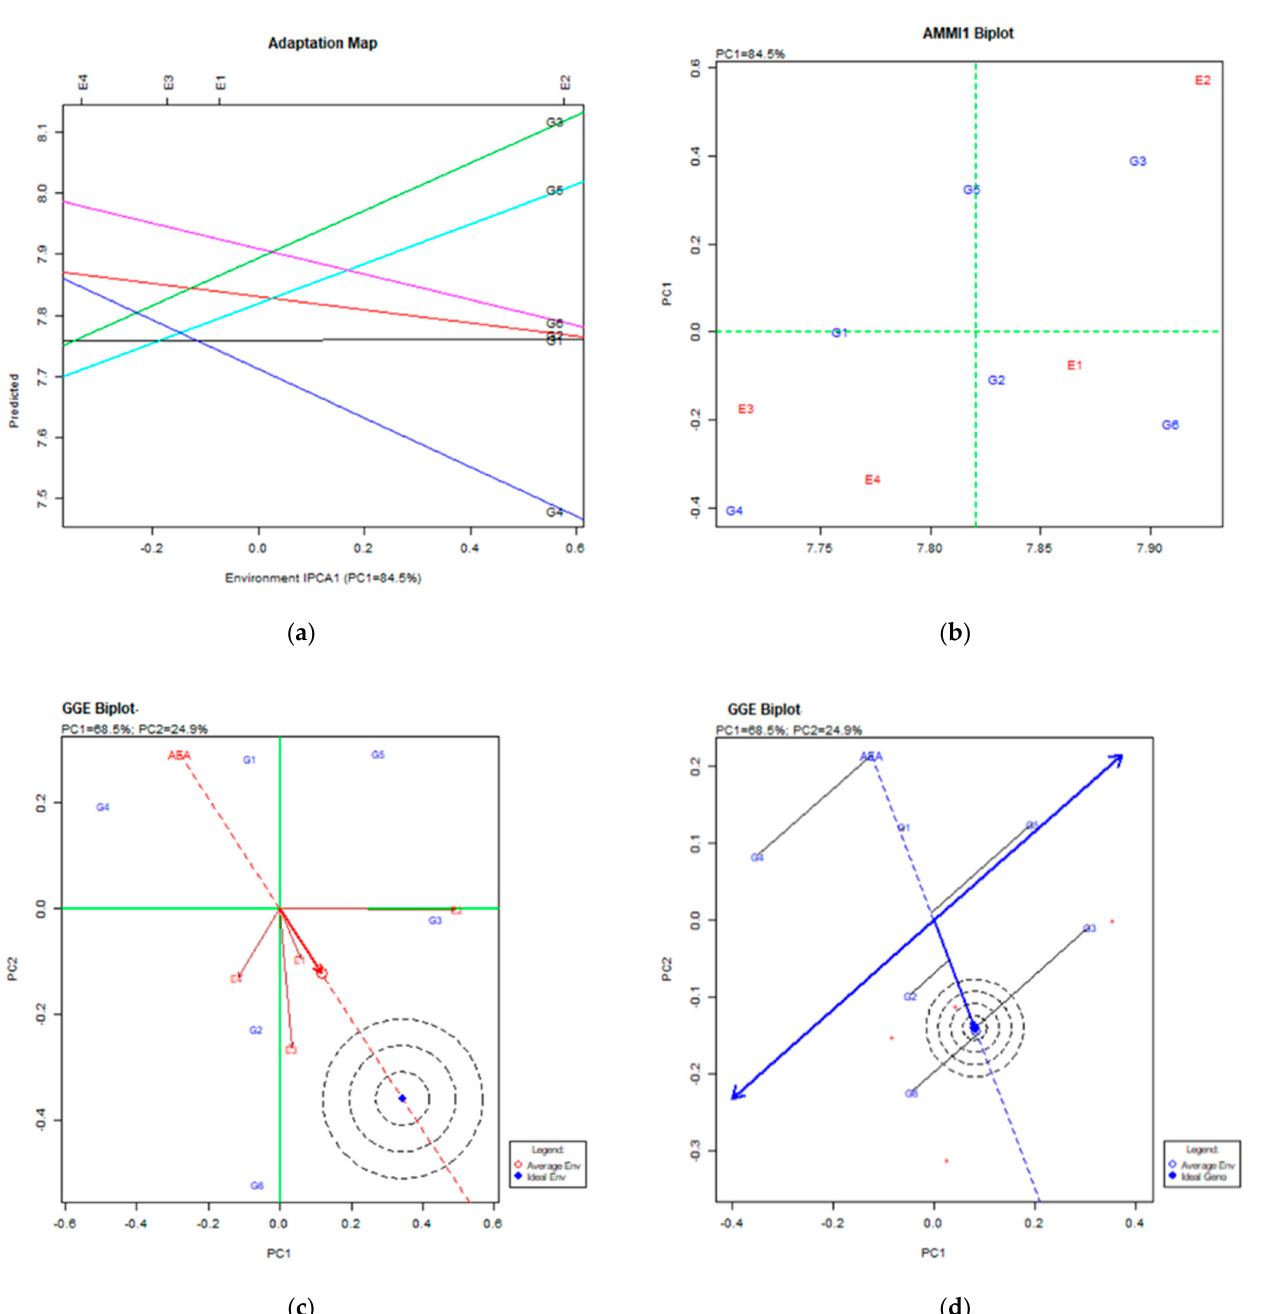
Figure 7. Stability analysis for ash content (%) based on: ( a ) the adaptation map where the X-axis (PC1) visualizes the stability of varieties over environments and the Y-axis—the performance of varieties for the trait; ( b ) the AMMI1 biplot where the Y-axis is the one visualizing the trait performance and the X-axis (PC1) visualizes the stability of varieties over environments; ( c ) the GGE biplot for environments depicting the stability of the environments over years via the placement as near as possible to the ideal and average environment; ( d ) the GGE biplot for varieties depicting the stability of the varieties over environments where the productive varieties are those to the right on the AEA vector and the stable ones are those which are as close to the AEA axis as possible.